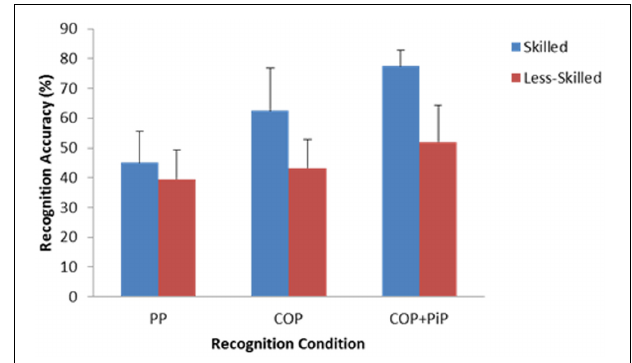
FIGURE 3 | The Skill × Display interaction on anticipation accuracy (+1 SD). PP is Condition 1 (Peripheral Players only); COP is Condition 2 (Central Offensive Players only); COP+PiP is Condition 3 (Central Offensive Players + ball and Player in Possession